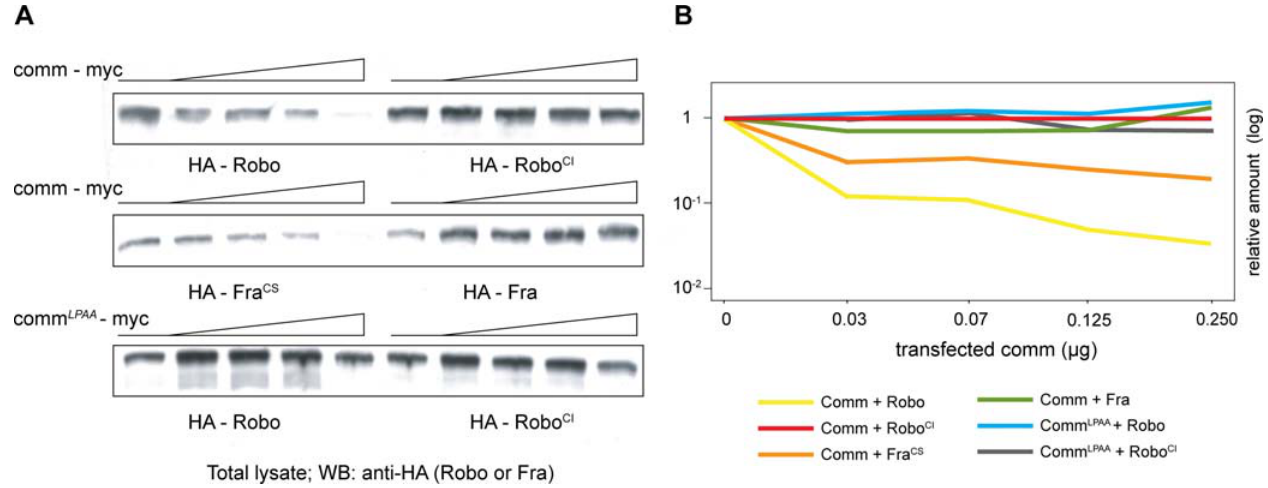
Figure 3. Robo SD is insensitive to Comm degradation in vitro. (A) Western Blot analysis showing an inverse correlation between total levels of detectable Robo and growing amount of Comm protein in COS7 cells. Cells were transfected with 0, 0.03, 0.06, 0.120 and 0.250 micrograms of Comm-myc (upper two panels) or myc tagged Comm LPAA (lower panel) plasmidic DNA and 0.5 micrograms of HA-tagged Robo, Robo SD , Frazzled or Frazzled CS . (B) Quantification of signal intensity of (A).